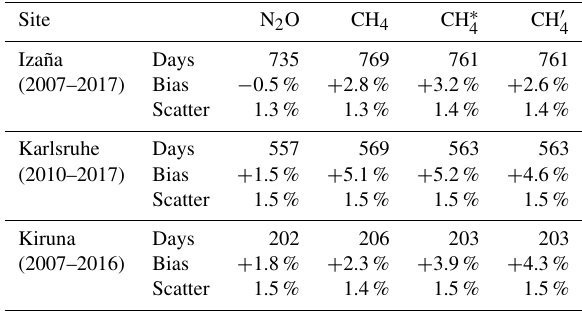
Table 7. As Table 6, but for retrievals in the UTLS region (Tenerife: 12km; Karlsruhe: 10.9km; Kiruna: